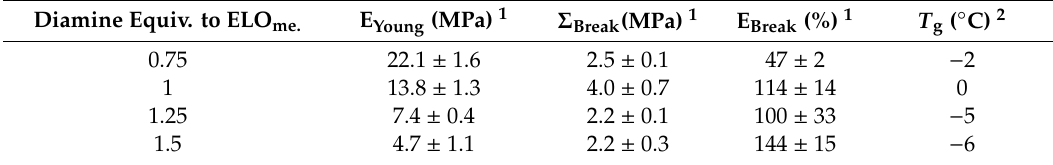
Table 2. The e ff ect of the diamine content on the thermomechanical properties of the epoxy resins. Diamine Equiv. to ELO me.